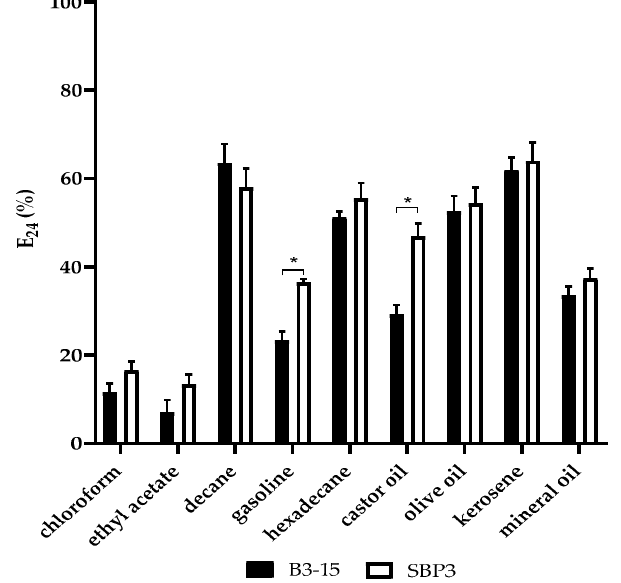
Figure 4. Ability of CFSs from B3-15 and SBP3 strains to emulsify (E 24 ) different hydrocarbons (1:1, v / v ) and vegetable oils. Data are expressed as averages and standard deviations (n = 3). * Significantly different ( p < 0.05).